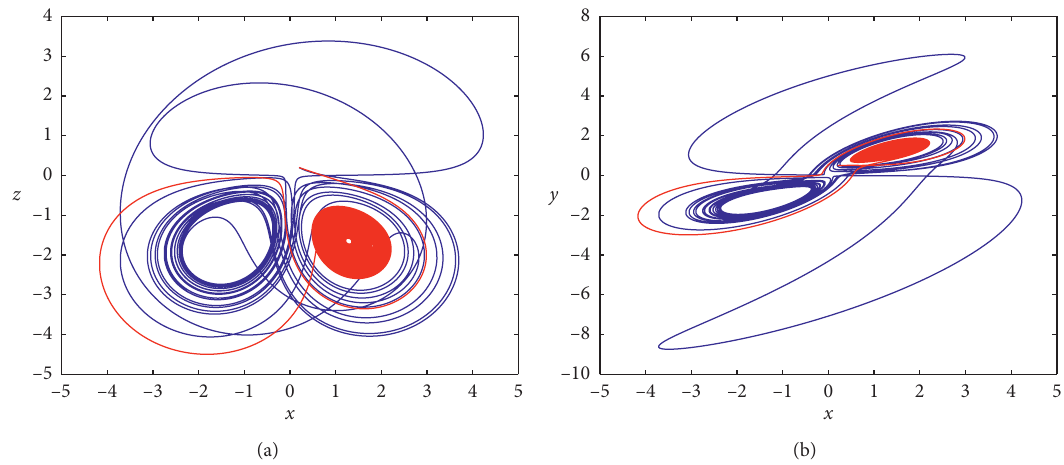
Figure 24: (a) Portrait at a � 0 . 65 in the plane ( x,z ) . (b) Portrait at a � 0 . 65 in the plane ( x,y ) .